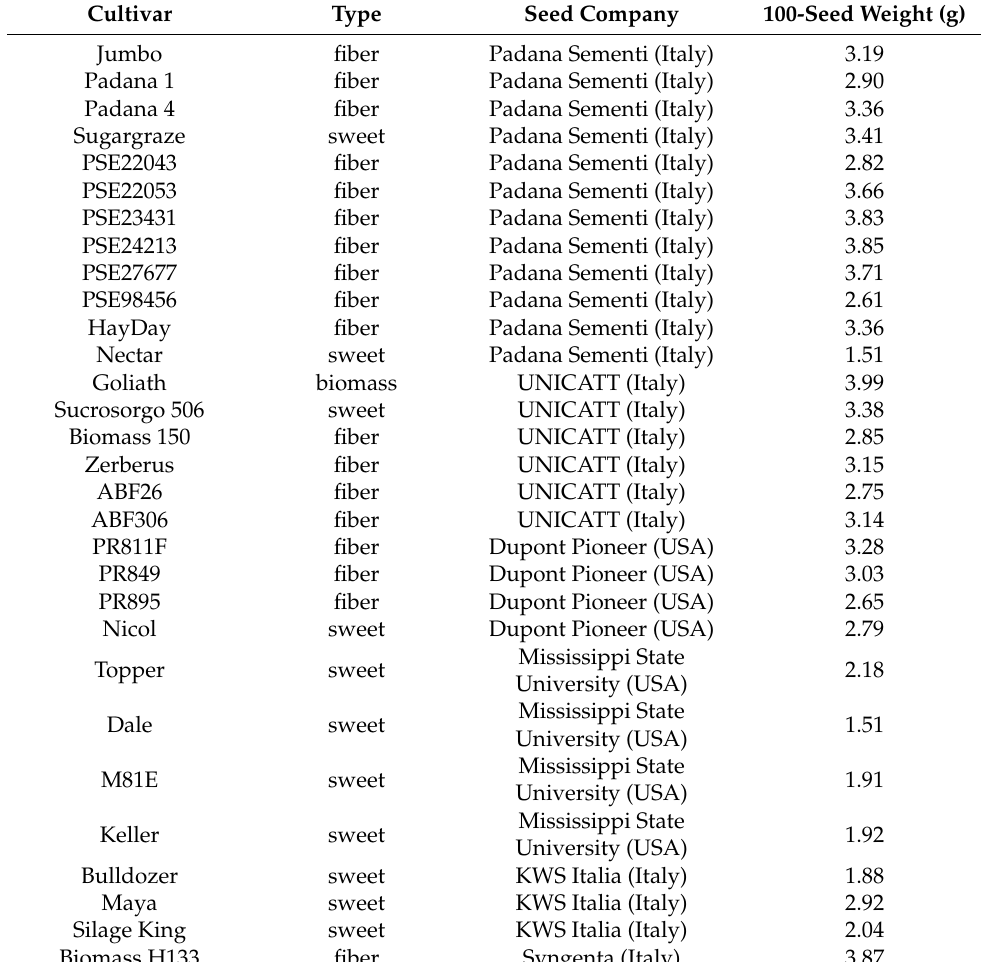
Table 1. List of the cultivars of sorghum assessed in the